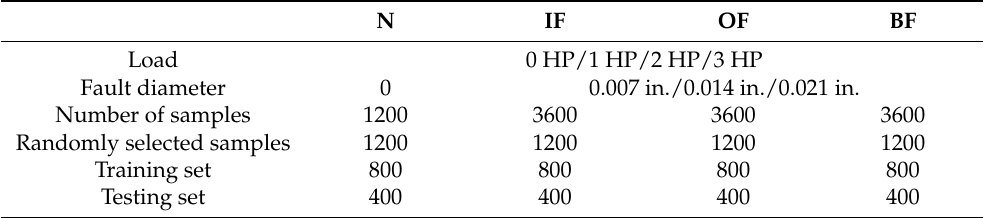
Table 2. Rolling Bearing fault sample